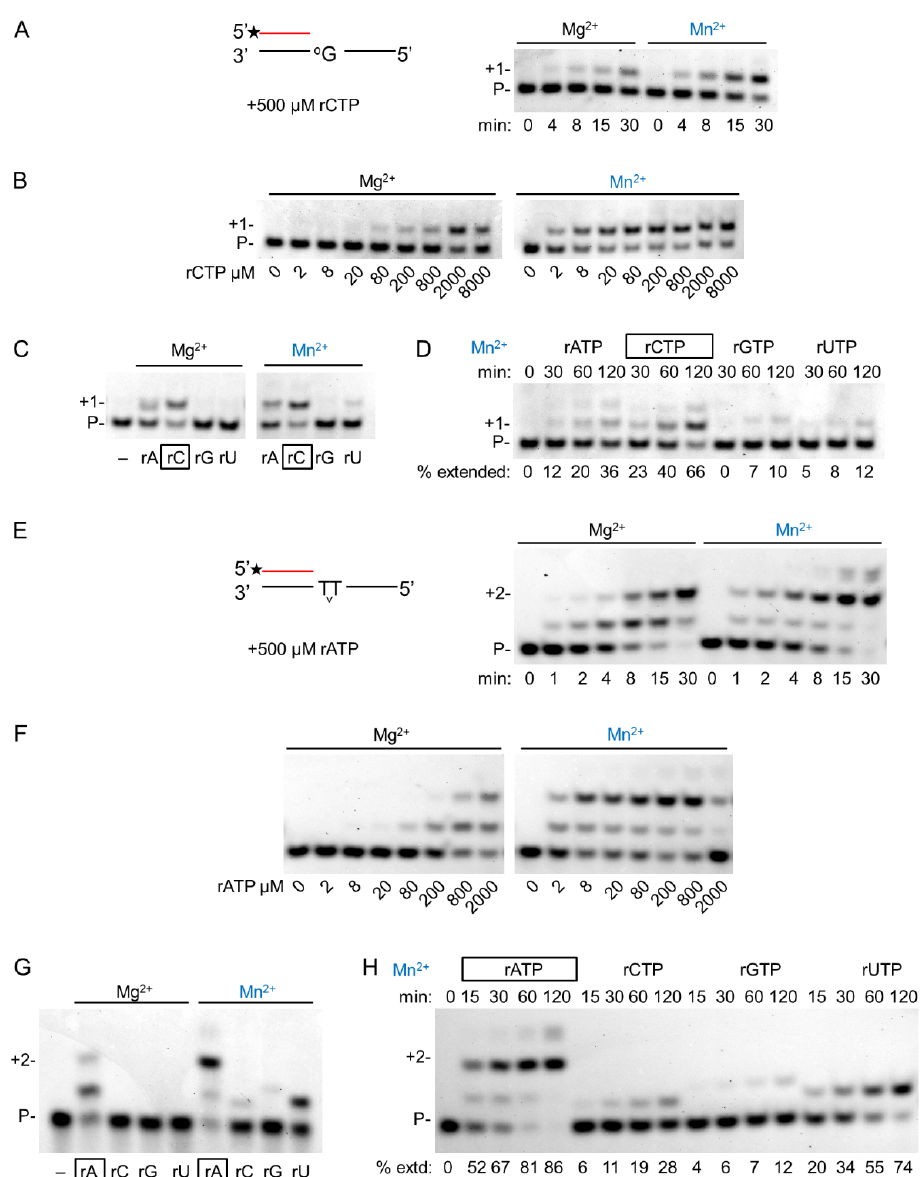
Figure 6. DNA damage bypass by hPol η during RNA synthesis using magnesium or manganese.